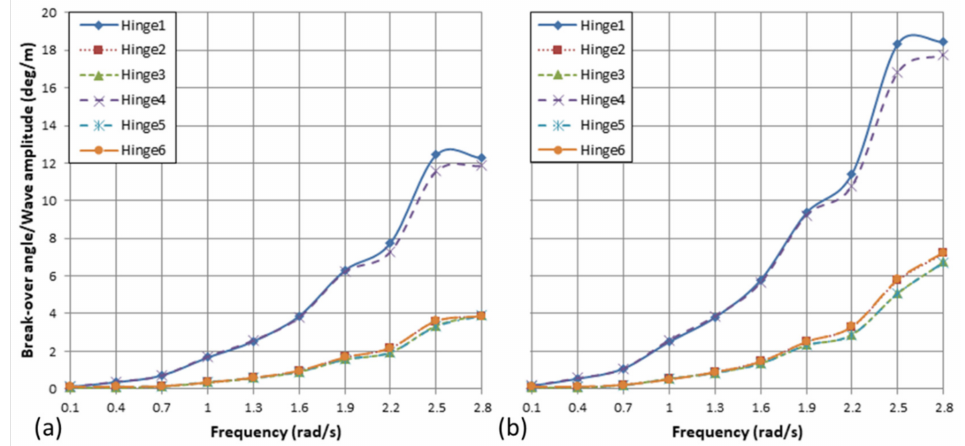
Figure 9. The hinge rotation angle at: ( a ) 1 m of wave amplitude and ( b ) 1.5 m of wave amplitude. In the case of bodies 4 and 1, the maximum rotation angle was large, about 1.5 degrees and 2.1 degrees more than in the 0.5-m amplitude wave, respectively. The variations in the rotation angles for the 1.5-m wave amplitude reached double of the initial study